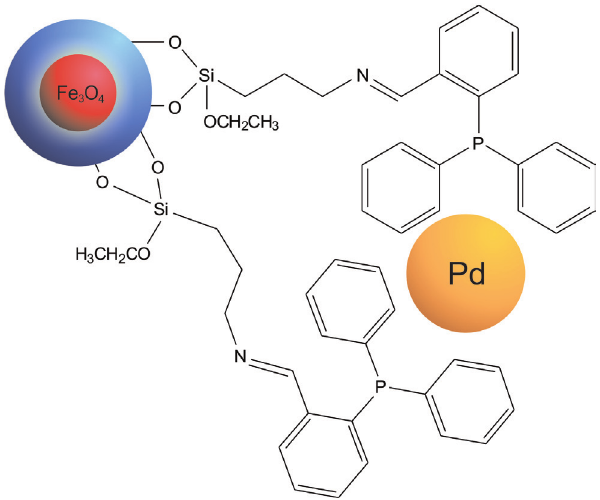
Figure 11 Core-shell silica-coated magnetite functionalized with iminophosphine groups as support for palladium